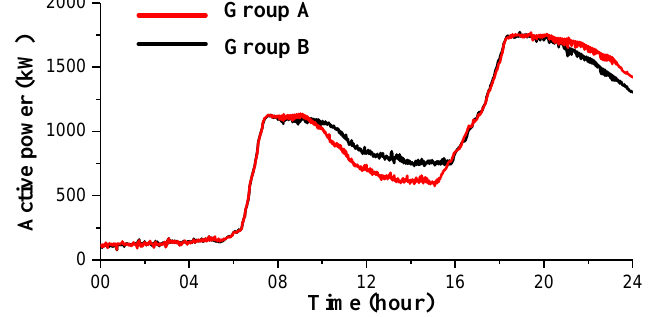
Figure 12. Optimization results of real time total active power consumption of groups A and B.